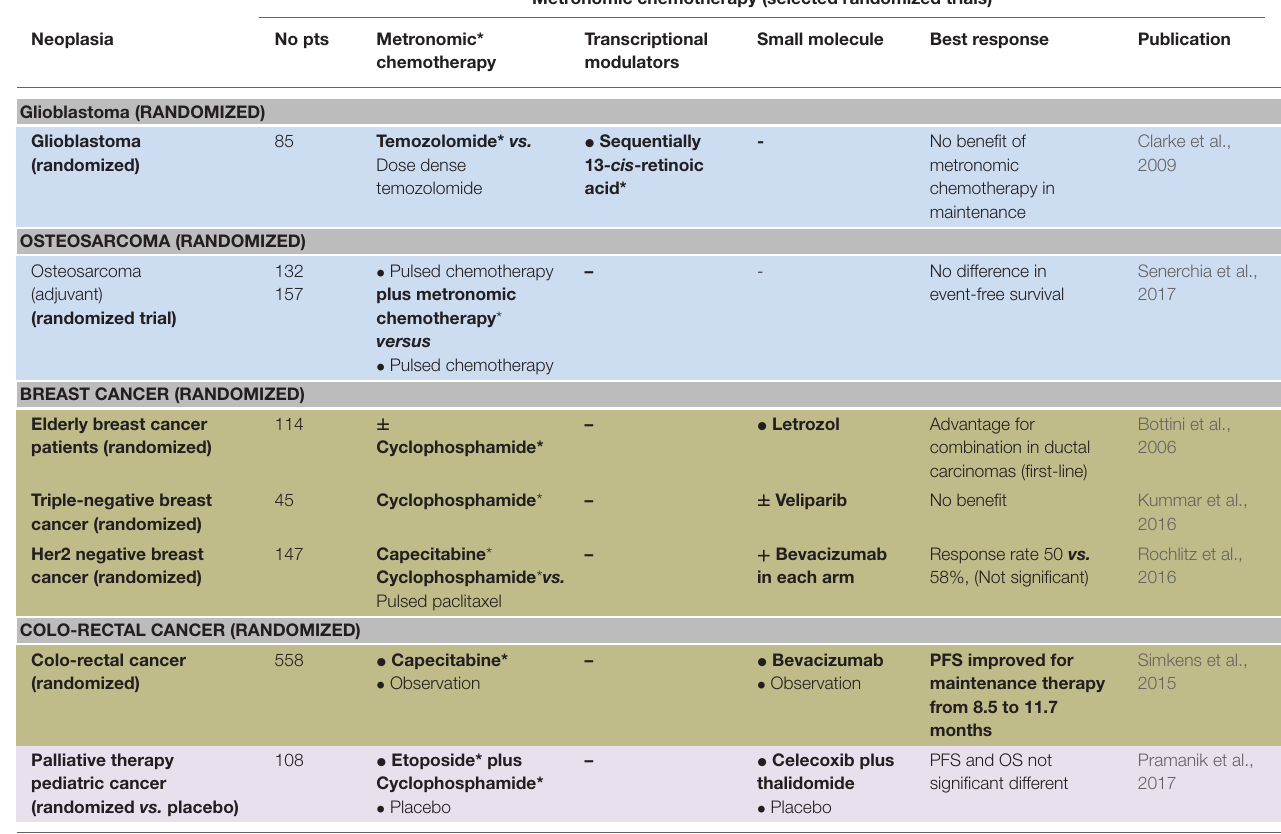
TABLE VIII | Communicative reprogramming of tumor